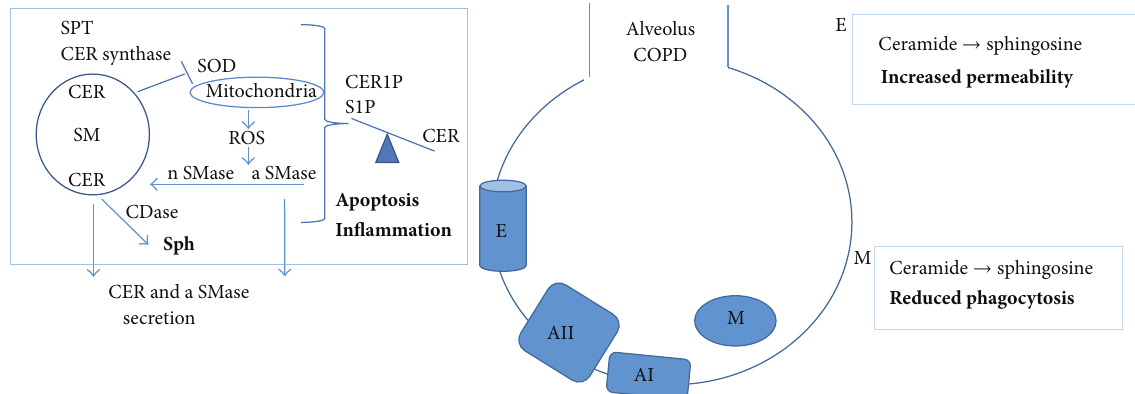
Figure 3: Sphingolipids modulation and bioactivity in COPD: prevalent sphingolipids alteration in the alveolar lung compartment and induced responses in endothelial cells (E), alveolar epithelial cells (alveolar type 1 AI, alveolar type 2, AII), and macrophages (M). SPT, Serine Palmitoyl Transferase; Cer, ceramide; SM, sphingomyelin; Sph, sphingosine; a SMase, acid Sphingomyelinase; n SMase, neutral Sphingomyelinase; CDase, Ceramidase; S1P, sphingosine-1-phosphate; Cer1P, ceramide-1-phosphate; ROS, reactive oxygen